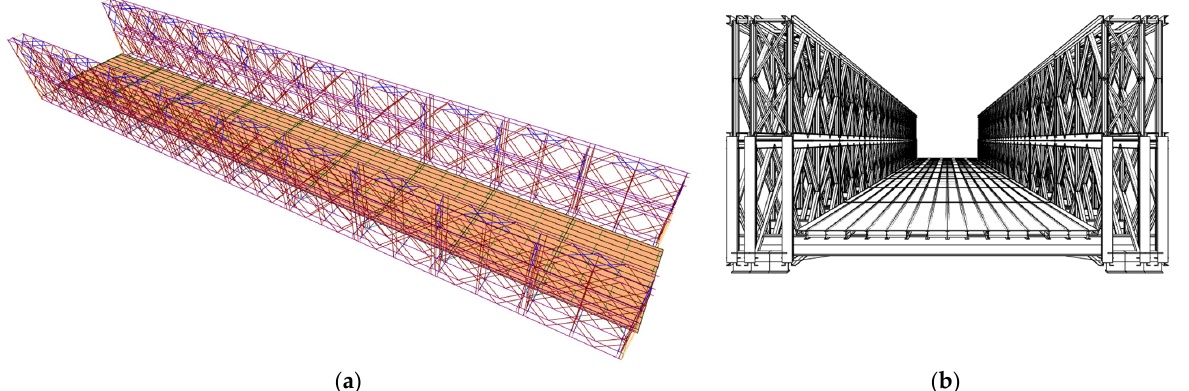
Figure 9. Geometry of compete spatial FEM model in the case of the longest analysed span TD-36 (120 ft): ( a ) model from beam and shell elements; and ( b ) front view visualization.